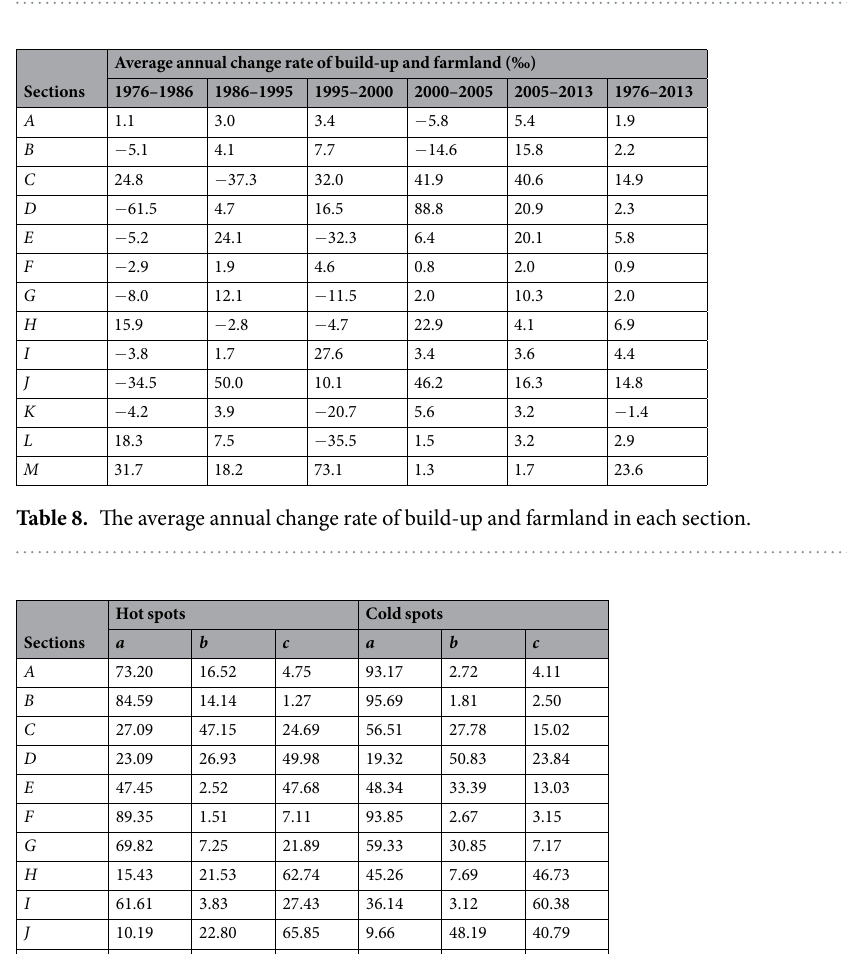
Table 7. The main land-use types comprise percent of the total area of the section in the riparian zone from 1976 to 2013. “ a ”: build-up and farmland; “ b ”: forest and grassland; “ c ”: wetland.